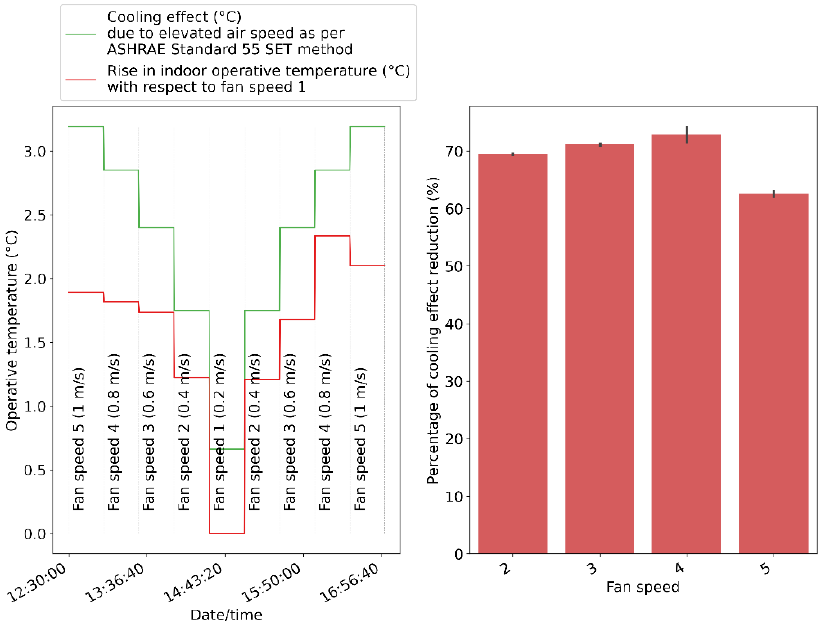
Figure 11. Cooling effect and rise in indoor operative temperature due to elevated air speed ( left ); percentage of negated cooling effect due to rise in indoor operative temperature ( right ).